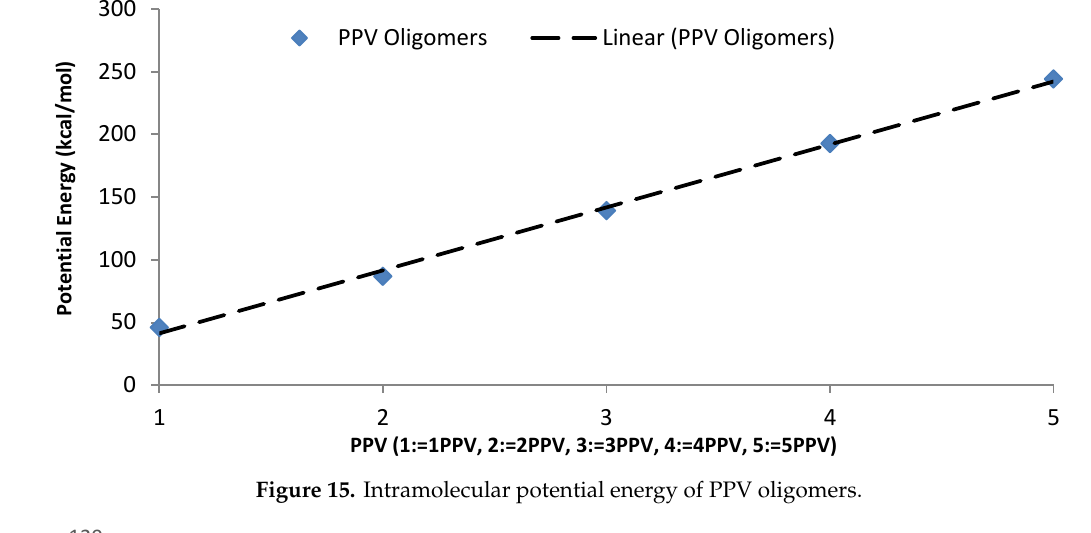
Figure 15. Intramolecular potential energy of PPV oligomers.